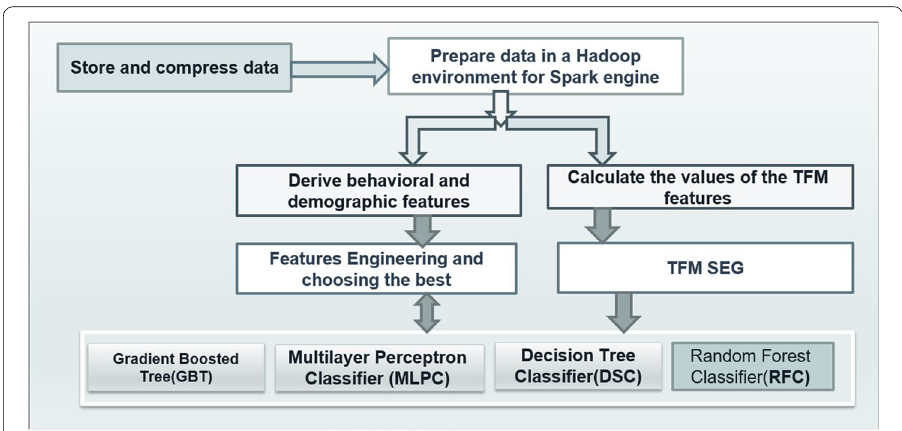
Fig. 9 Steps required for the proposed